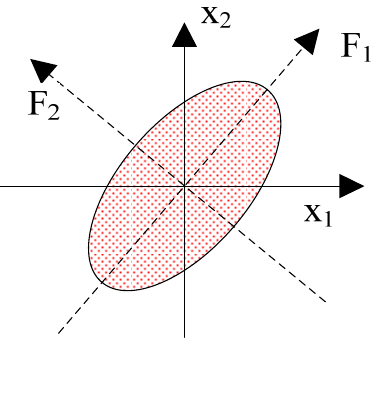
Figure 1. Geometric Illustration of